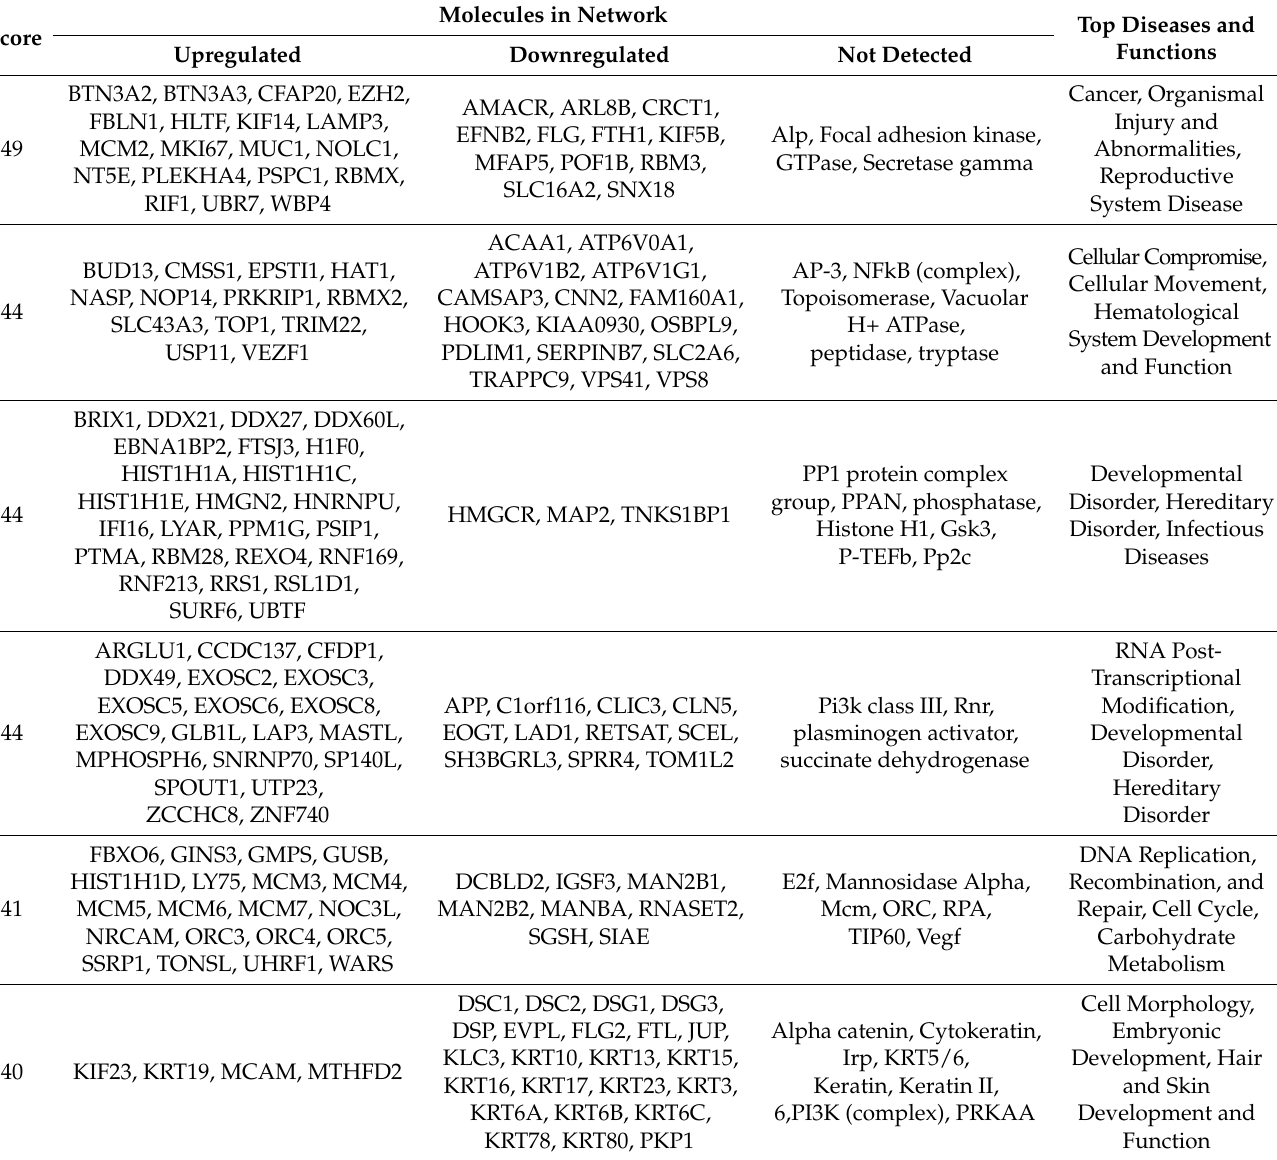
Table 3. Twenty-five protein networks were identified by IPA based on the proteins differentially altered in abundance by ≥± 1.5-fold change in cells expressing HPV16 E6 and E7 compared to control cells. In addition to up and down regulated molecules, proteins predicted by IPA to participate in a particular network, although not detected by our LC-MS/MS experiments, are also listed. The score reflects the probability of finding the observed proteins in a given network by random chance. A higher score value reflects a lower probability. The top diseases and functions associated with proteins in each network are listed. Multiple networks may have similar biological functions or disease